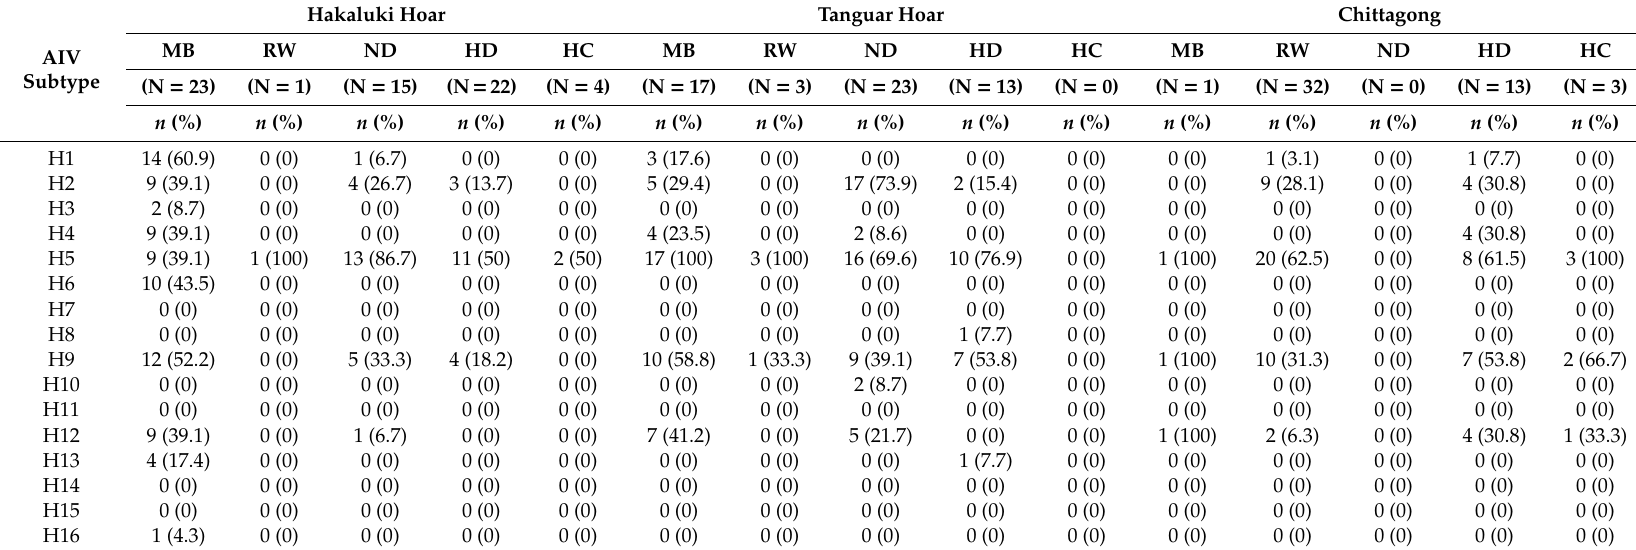
Table 3. Area versus haemagglutinin (HA) serotypes for di ff erent groups of birds in